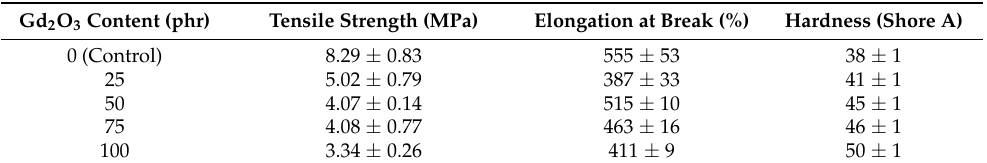
Table 4. Mechanical properties of tensile strength, elongation at break, and hardness (Shore A) of Gd 2 O 3 /NR composites containing varying Gd 2 O 3 contents of 0, 25, 50, 75, and 100 phr. Values are shown as mean ± standard deviation.